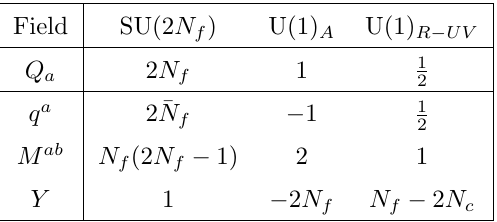
Table 2 . Charges of the (cid:12)elds in the symplectic